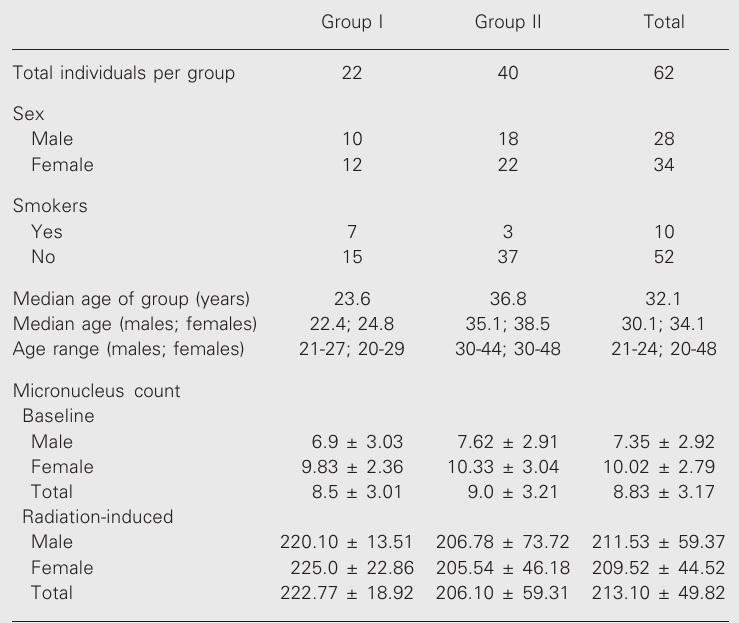
Table 1. Frequency of baseline and radiation-induced micronuclei in healthy adults of both genders.